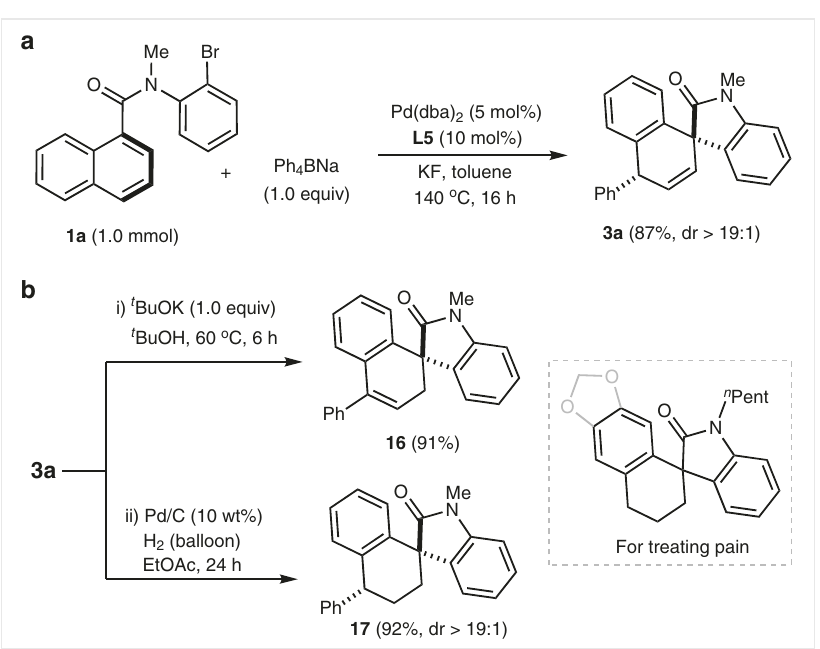
Fig. 7 Scale-up reaction and synthetic transformations. a 1.0 mmol scale-synthesis of product 3a . b Transformations of product 3a . (i) isomerization of carbon – carbon double bond of 3a with t BuOK. (ii) reduction of carbon – carbon double bond of 3a with Pd/C catalyst under H 2 extended to three-component dearomative 1,4-vinylarylation of naphthalenes with alkynes and tetraarylborates. The dearomative 1,4-difunctionalization reaction has provided facile accesses to unique spirocyclic compounds. DFT calculations revealed the reaction mechanism and elucidated the origins of chemo- and regioselectivities. It is the facile exergonic insertion of naphtha- lene double bond that disrupts the sequence of direct Suzuki coupling, leading to the tandem Heck/Suzuki coupling reaction. The steric repulsions between the aryl group of the forming C − C